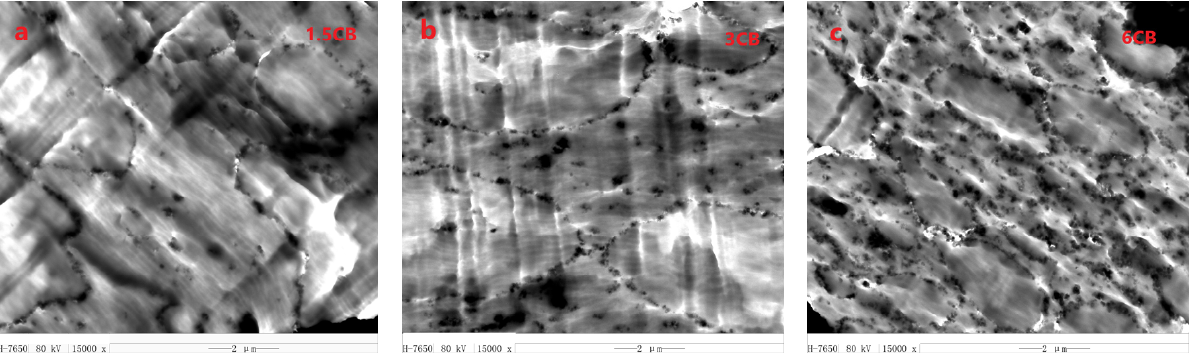
Figure 3. TEM micrographs of PA6/PBT(50/50)-CB composites containing different CB contents.